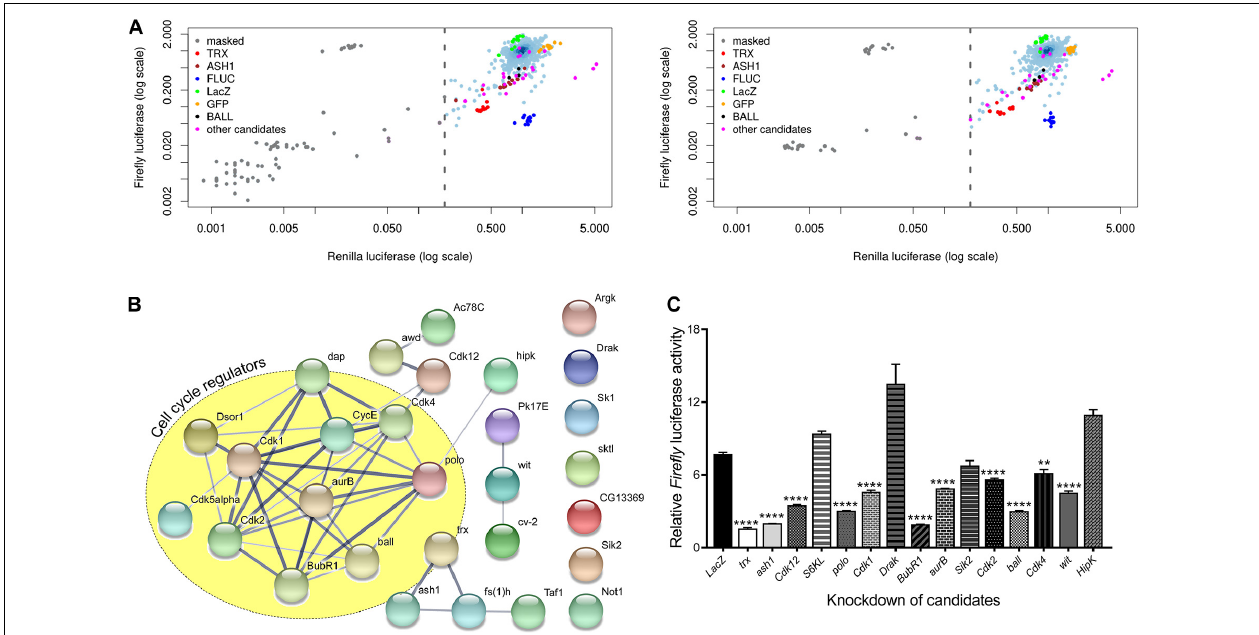
FIGURE 1 | Kinome-wide RNAi screen data analysis and validation. (A) Scatterplots of the plate median corrected intensity values for Firefly luciferase (F.Luc) against the plate median corrected intensity values for Renilla luciferase (R.Luc). To generate a list of trxG candidate genes that affect gene activation, Z-scores of trx (red) and ash1 (maroon) knockdowns were used to set cut-off value which is represented by a dashed line. Knockdown of trx (red) and ash1 (maroon) as well as knockdown of F.Luc (blue) were used as positive controls. Cells treated with dsRNA against LacZ (green) and GFP (orange) served as negative controls. Genes affecting activity of both F.Luc and R.Luc were masked (gray) and were not investigated further. Ball is shown in black whereas the remaining eight candidates which were reproduced in the secondary screen are shown in magenta. Data shown represents two independent experiments of the kinome-wide RNAi screen. (B) Protein-protein interaction network of candidate genes generated using STRING database (Snel, 2000; Szklarczyk et al., 2019). Nodes depict proteins that are connected by lines of varying thickness. Thickness of lines demonstrates the degree of confidence for the interaction between connected nodes. The yellow circle is marking candidates that are known to associate with cell cycle regulation. A confidence level of 0.400 was used to generate the interaction map. (C) D.Mel-2 cells treated with dsRNA against selected serine-threonine kinases from the list of candidate genes from primary screen were transfected with the experimental reporter ( F.Luc ) and invariant co-reporter ( R.Luc ). Knockdown of all but four kinases resulted in significantly lower relative Firefly luciferase activity when compared to cells treated with dsRNA against LacZ . Cells treated with dsRNA against trx and ash1 were used as positive control. Experiment was performed in triplicate and independent t -tests were done for statistical analysis (** p ≤ 0.01, or **** p ≤